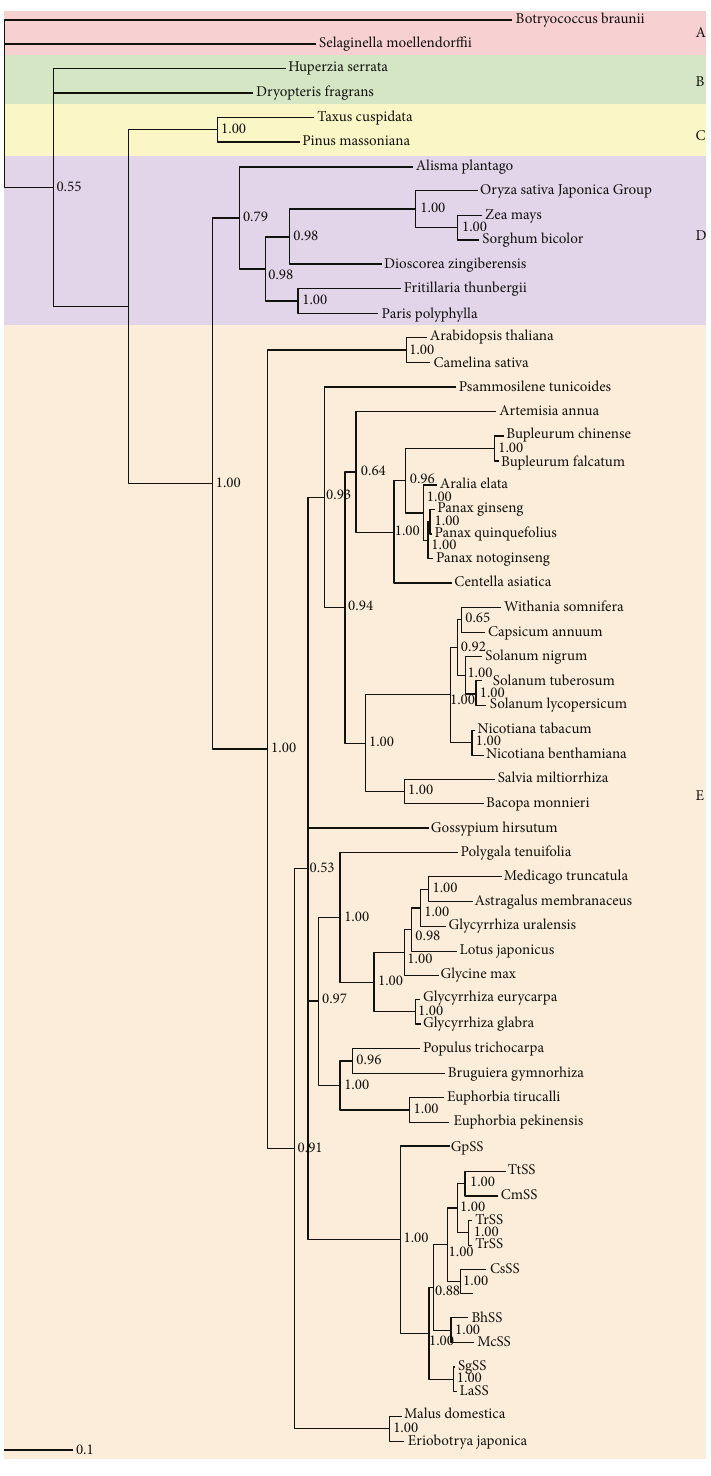
Figure 2: Phylogenic tree of terrestrial plant SQS was inferred by Bayesian analyses and divided into fi ve clades. Botryococcus braunii and Selaginella moellendor ffi i were used as outgroup A. Pteridophyte, Gymnosperms, Monocotyledons, and Dicotyledons were labeled as groups B, C, D, and E, respectively. Posterior probabilities are labeled above branches. Numbers indicate the Bayesian probabilities